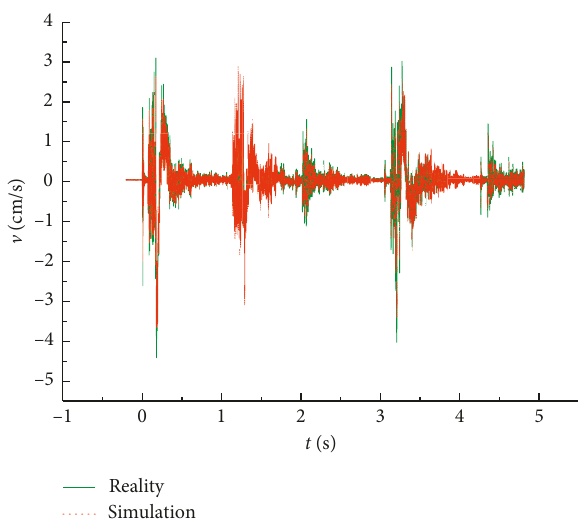
Figure 22: Real blasting wave (green wave) and simulated blasting wave (red dotted line wave).